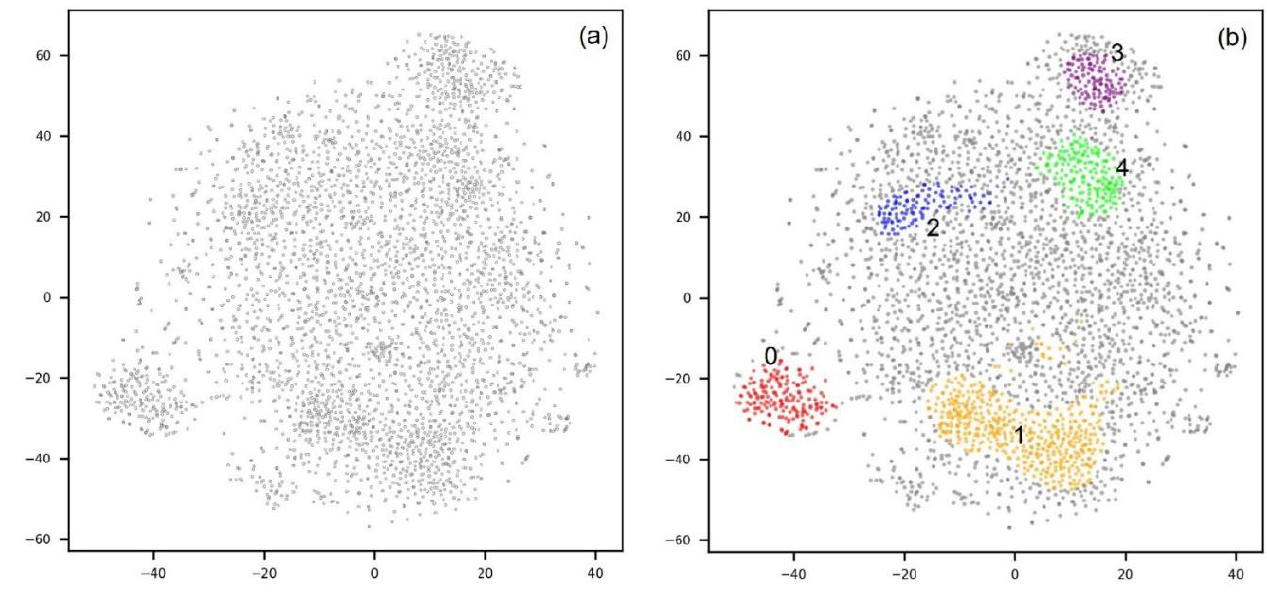
Figure 11. Insadong photos: ( a ) two-dimensional visualization; ( b ) result of HDBSCAN. Table 3. Number of photos for each cluster generated as a result of HDBSCAN in Insadong. Cluster